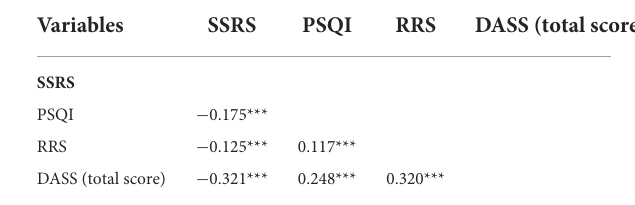
TABLE 2 Correlations of all tested variables.